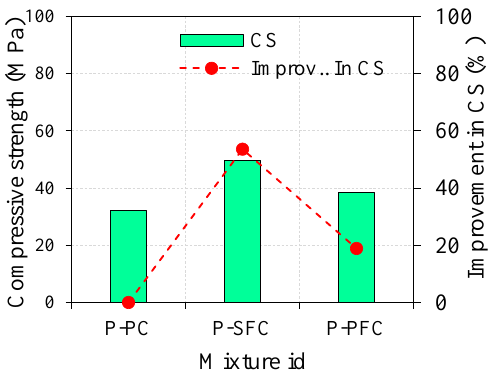
Figure 6. Compressive strength of PAFC.